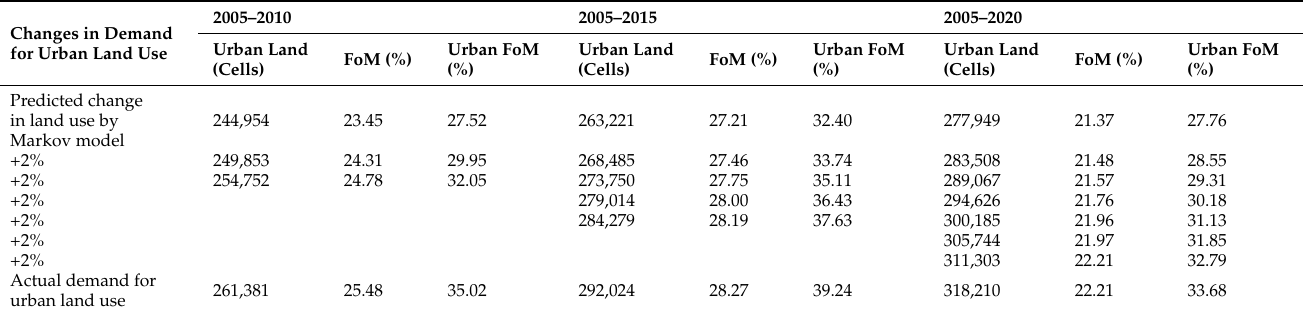
Table 1. Sensitivity of the MKCA RF-AS model to demand for urban land